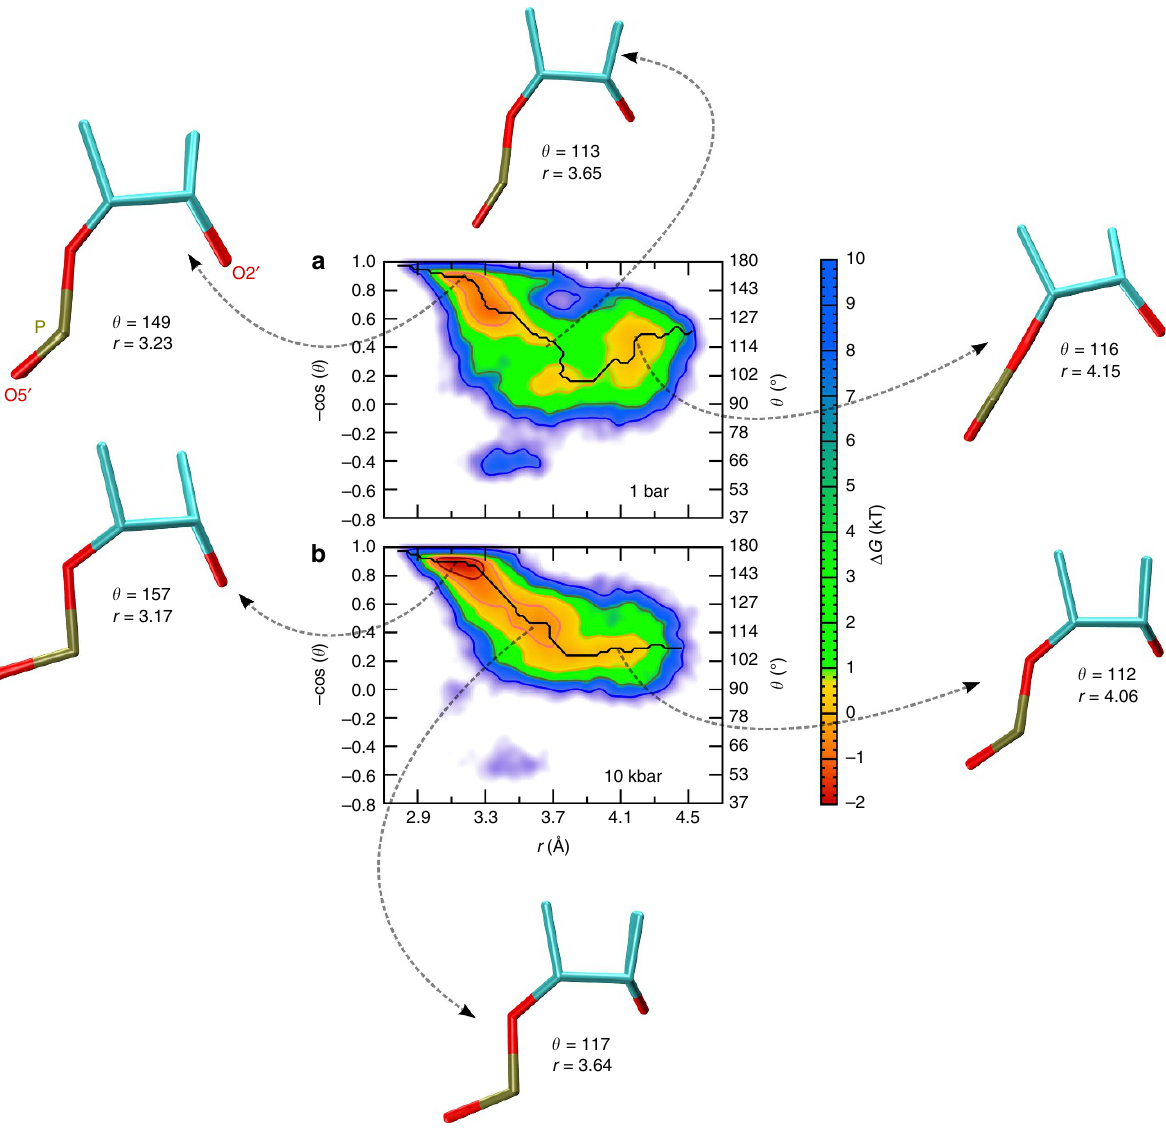
Figure 5 | Gibbs free-energy landscapes of the activated precursor state AP of mod-HpRz. ( a ) 1 bar and ( b ) 10kbar at 300K in the two-dimensional subspace spanned by the negative cosine of the attack angle -cos( y ) (the approximate y scale is reported on the right axis) and the attack distance r as defined in Fig. 4; the free energies are reported relative to the inactive region. The presented structural fragments (see Fig. 4) together with the provided angles and distances in a , b have been obtained by averaging the configurations corresponding to the three relevant regions along the minimum free-energy pathways (see Fig. 6) that are referenced by using dotted arrows in the free-energy